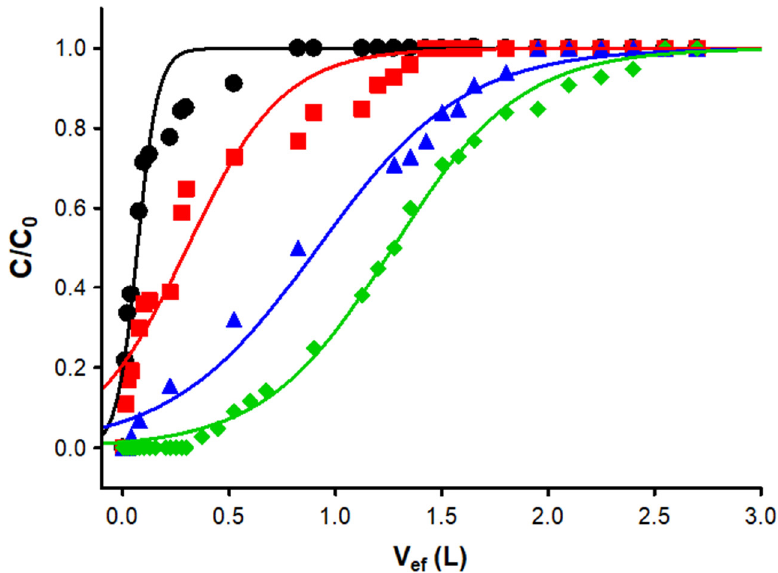
Figure 7. Breakthrough curves obtained from adsorption tests in a continuous flow using 0.4 g of adsorbent (Z = 1 cm), 2.5 mL min − 1 y C 0 = ● 50 mg g − 1 , ■ 25 mg g − 1 , ▲ 10 mg g − 1 y, and ♦ 5 mg g − 1 . adsorbent (Z = 1 cm), 2.5 mL min − 1 y C • 50 mg g − 1 , (cid:4) 25 mg g − 1 , (cid:78) 10 mg g − 1 y, and (cid:7) 5 mg g − 1 0 =